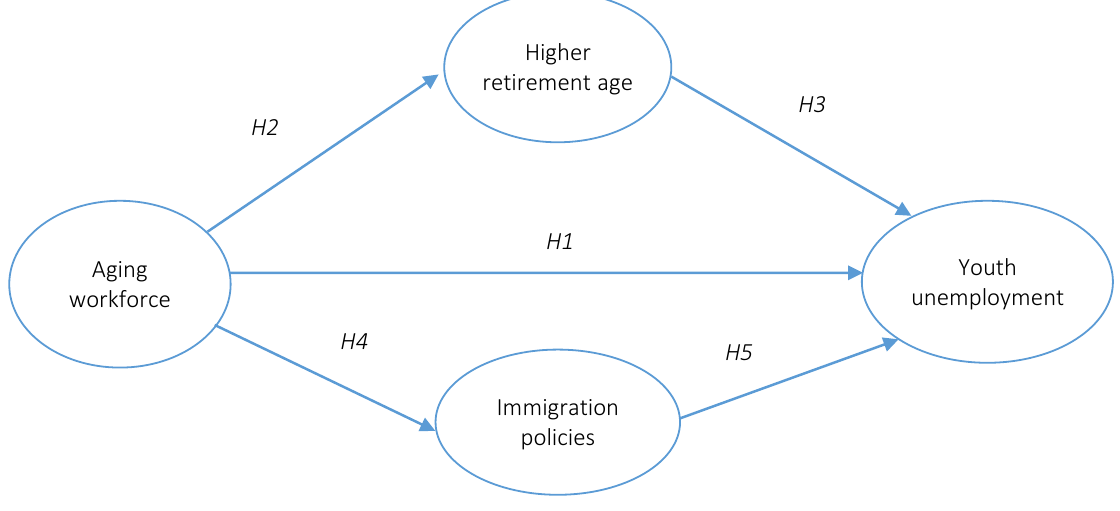
Figure 1. Conceptual